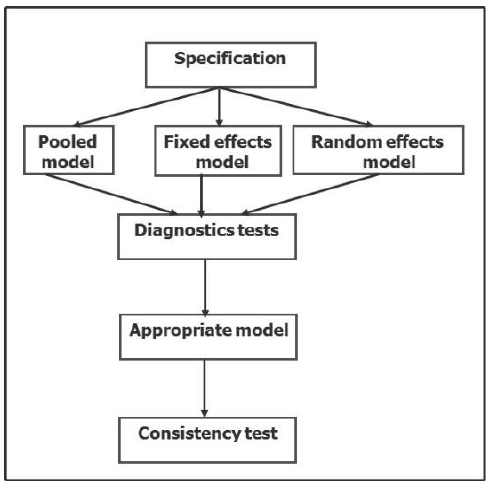
Figure 1. Panel regression and instrumental variables regression.